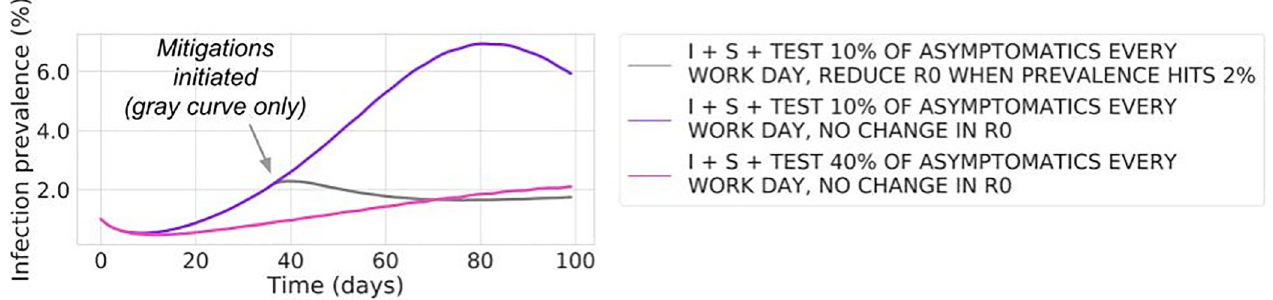
Fig 3. Workplace prevalence trajectories in the “University” case study, where workplace transmission can decrease as a result of mitigations introduced upon an increase in prevalence. Continuous testing allows an employer to estimate the current prevalence of infection in the workplace. This gives the employer the opportunity to introduce mitigations in response to increases in prevalence, reducing workplace spread. The gray curve shows the impact on workplace prevalence of testing 10% of asymptomatics per day but also reducing the workplace reproduction number (R0W, see S1 Table) from 4 to 2 (corresponding to initiating mitigations) when prevalence reaches 2%; note that prevalence trajectories are plotted as in Fig 2. The purple curve (10% asymptomatic testing with no change in R0W during the simulation) corresponds to the purple curve in Fig 2C, and the pink curve (40% asymptomatic testing with no change in R0W during the simulation) corresponds to the pink curve in Fig